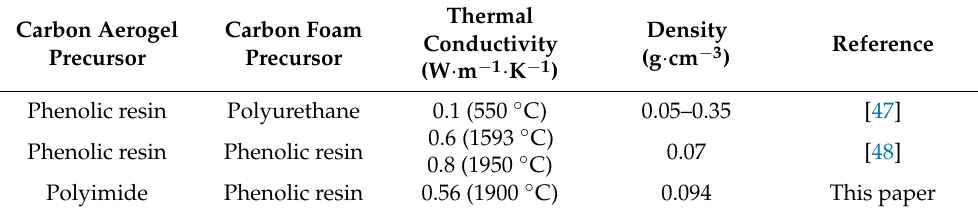
Table 3. Thermal conductivity of as-prepared insulated